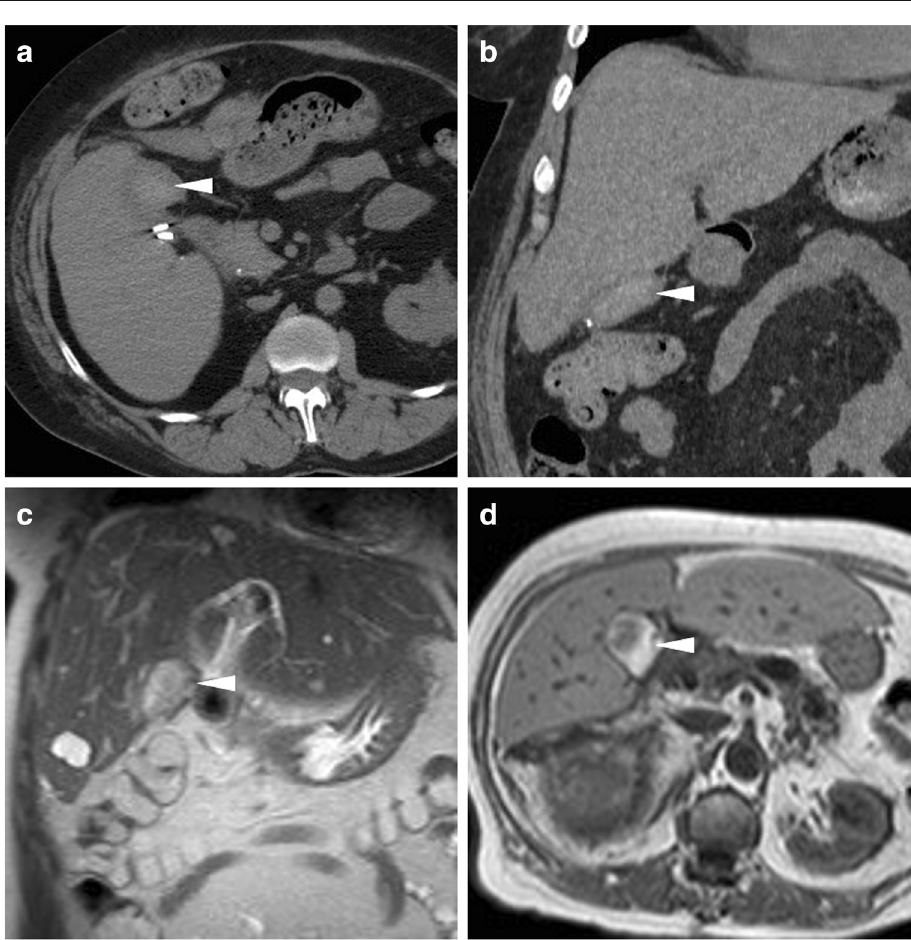
Fig. 5 Transient bloody collections in the surgical bed after uncomplicated laparoscopic cholecystectomy. a , b On the 8th postoperative day, unenhanced CT performed showed an ovoid, demarcated collection ( arrowheads ) with high attenuation consistent with resolving blood. c , d In another patient, on the 4th postoperative day, T2- ( c ) and T1- ( d ) weighted MR images showed a moderate- sized inhomogeneous collection ( arrowheads ) with signal intensi- ty features consistent with sub- acute blood. Both findings did not require blood transfusions or any